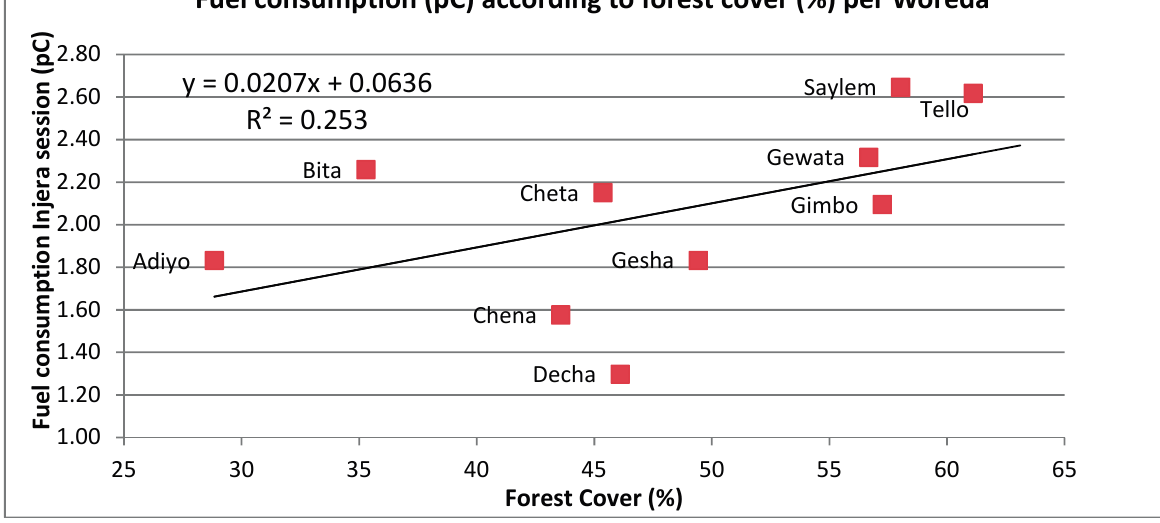
Figure 4. Fuel consumption kg/person according to forest cover (%).